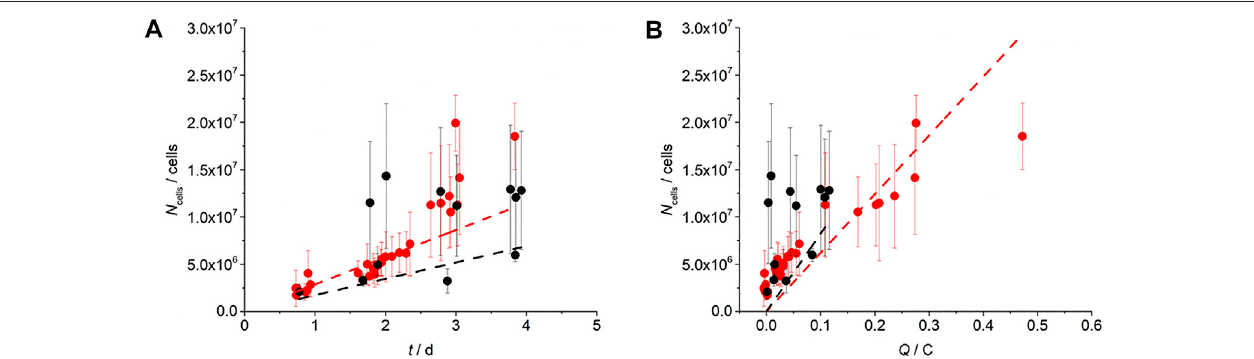
FIGURE 2 | Cell number ( N cell ) determined in vivo on a transparent AuPd WE during cultivation at +150 mV vs. Ag/AgCl sat. KCl as the function of time (A) and charge (B) .RedandblackdatapointsindicateEFCexperimentsbasedonpre-cultures1and2(each n =3),respectively.Dashedlinesindicatelinearregressionusedfor the calculation of single-cell yield coef fi cients ( Y Ne ). Error bars indicate the standard error from cell counting. Each data point represents the average of 10 analyzed microscopy pictures ( Supplementary Figure S3